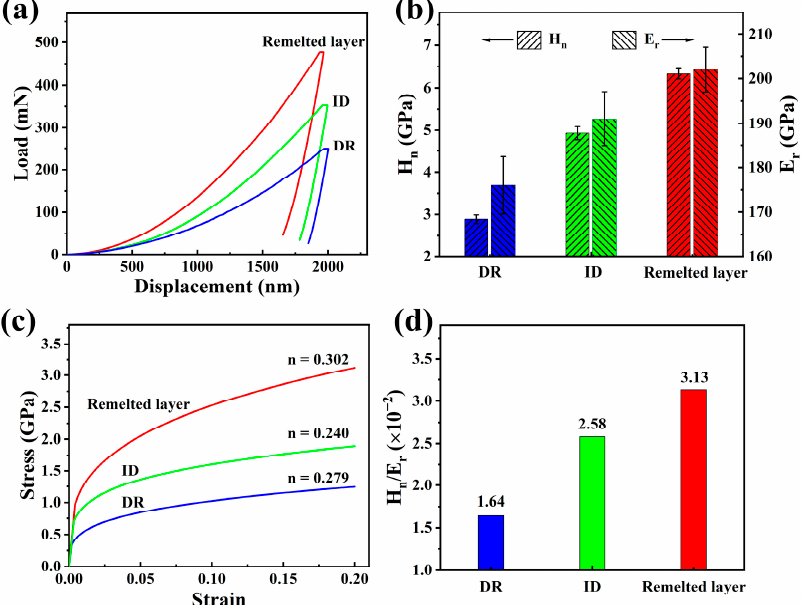
Figure 6. Nanoindentation analysis results. ( a ) Typical P–h curves; ( b ) H n and E r ; ( c ) calculated stress–strain curves; and ( d ) H n / E r ratios. Table 2. Nanomechanical properties of the substrate and the remelted layer obtained from the nanoindentation tests.